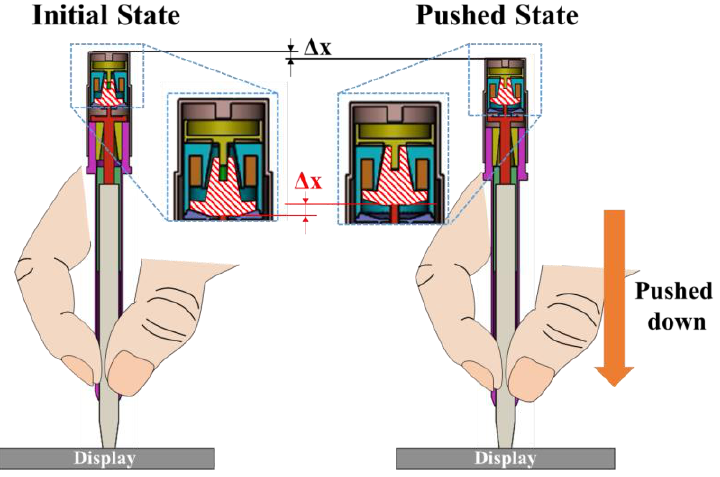
Figure 2. Operating principle of the proposed haptic stylus.